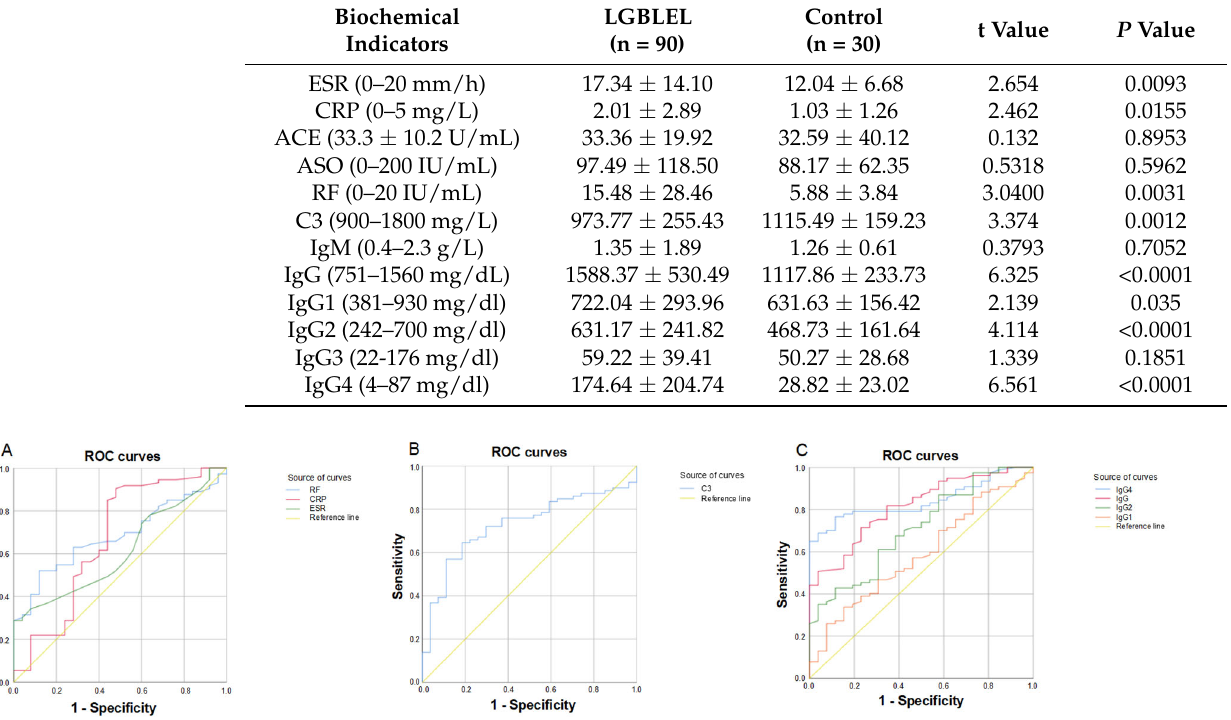
Table 1. Biochemical Indicators of the LGBLEL Patients and the Control Group. Biochemical